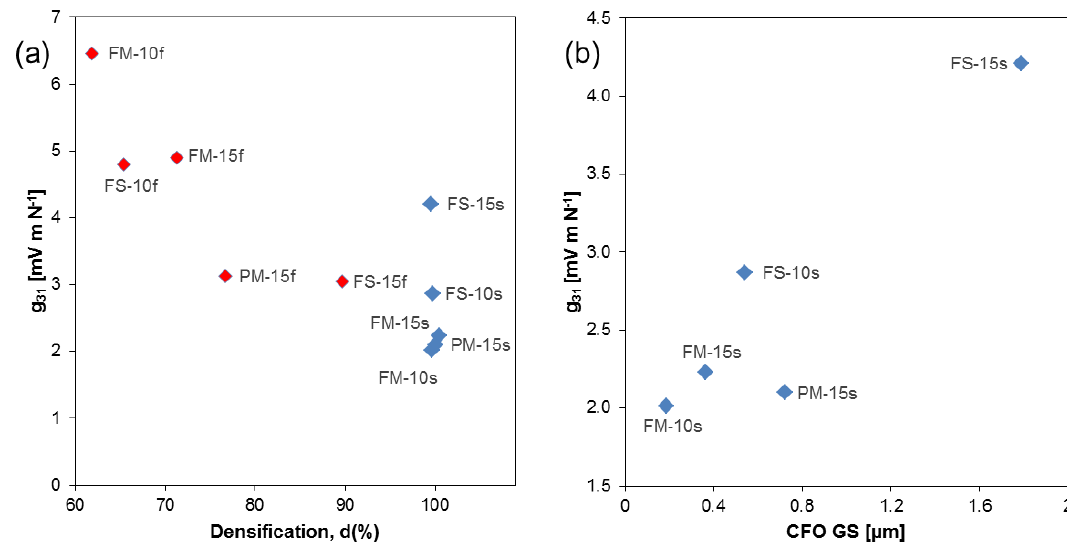
Figure 7. ( a ) g 31 as a function of densification (all samples); ( b ) g 31 vs. CFO grain size (fully densified samples only). Color coding as follows to aid the reader to evaluate correlations: red diamonds: fast sintered samples (f); blue diamonds: slow sintered samples